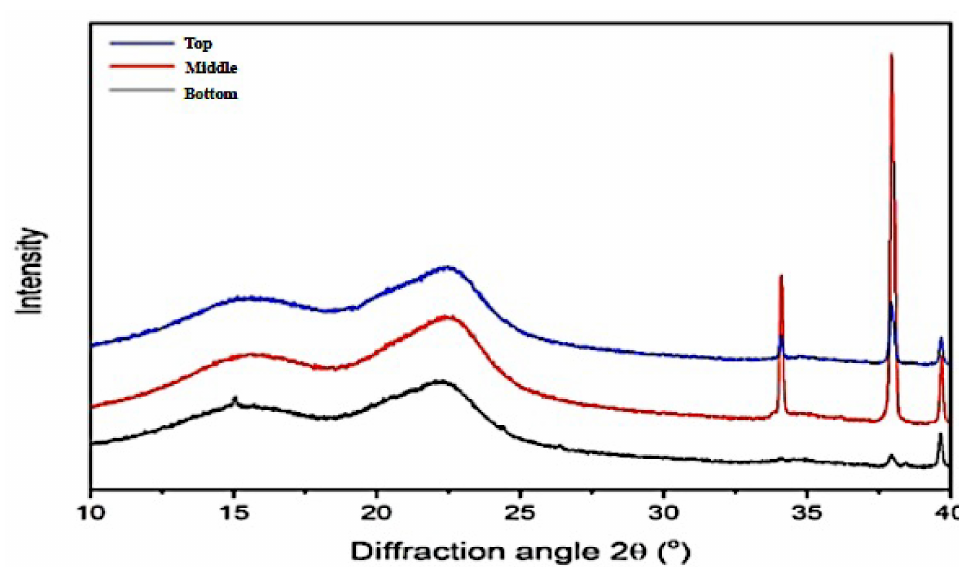
Figure 12. X-ray diffractograms of Gigantochloa pruriens bamboo based on axial position.